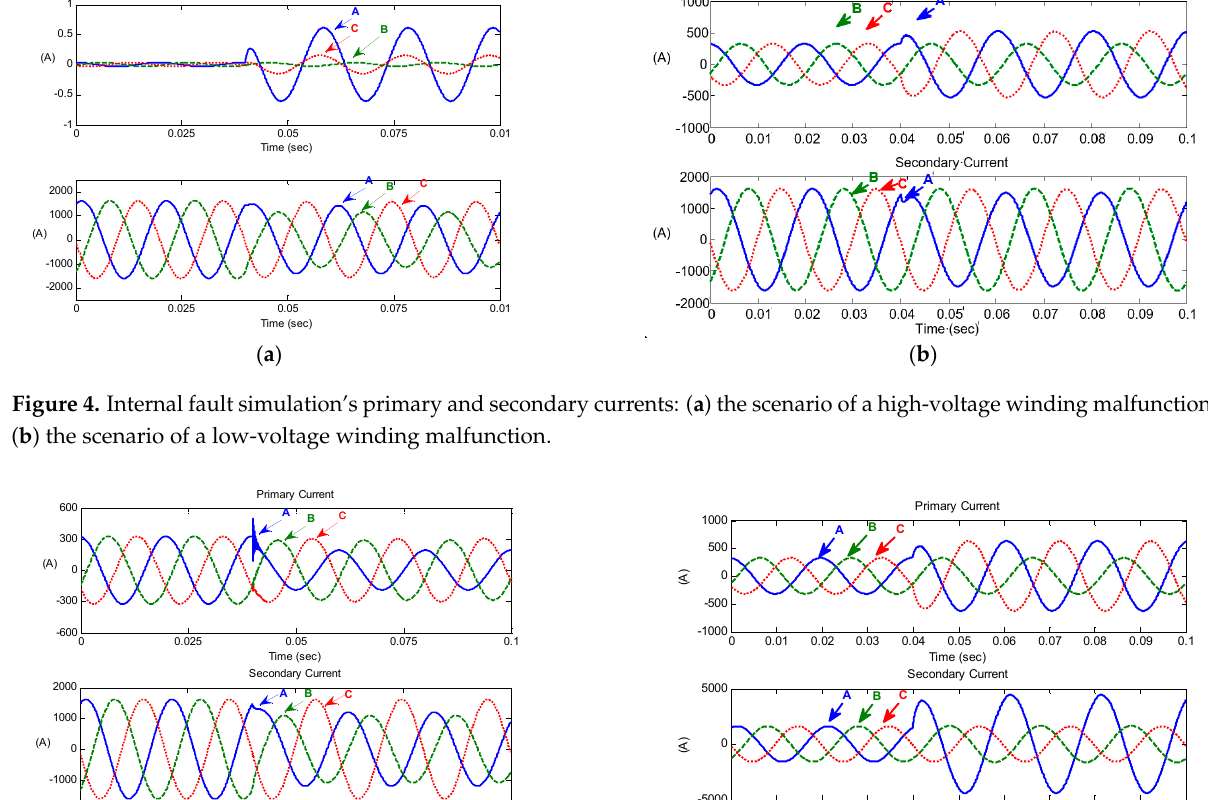
( b ) Figure 6. In the event of an internal winding problem, DWT of differential currents from scale 1 to scale 5: ( a ) analysis of high-voltage winding faults; ( b ) analysis of low-voltage winding faults.